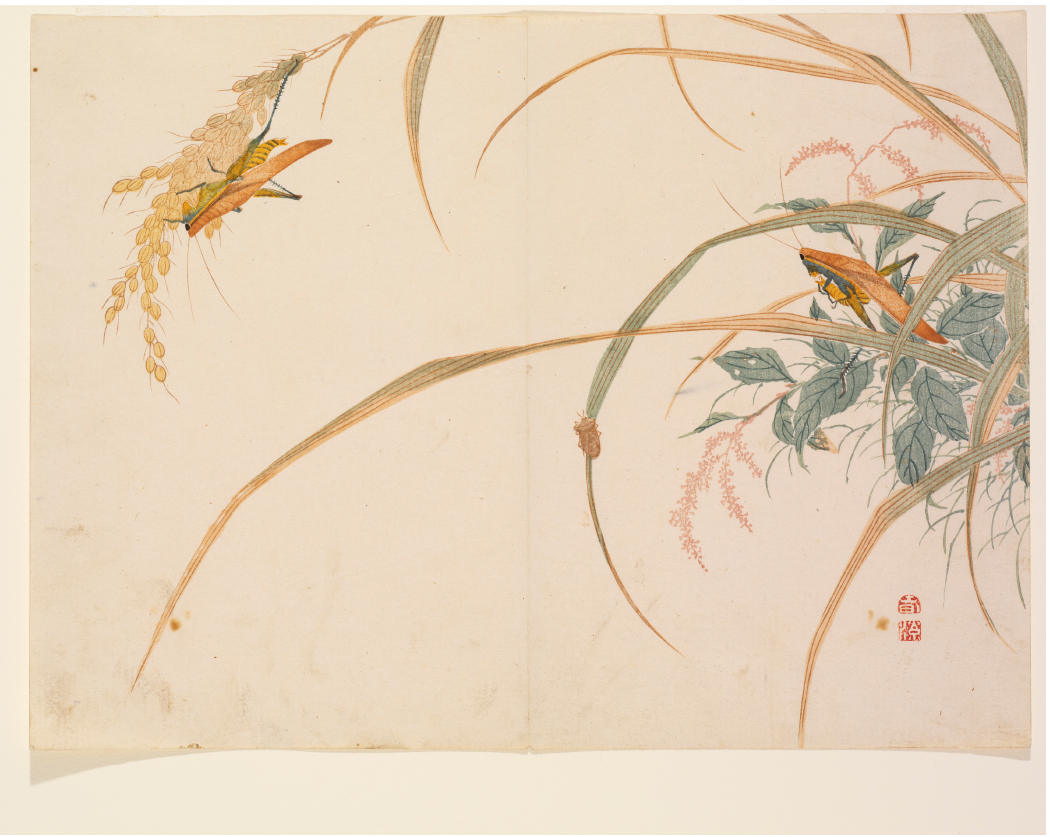
Figure 2. Grasshopper and bee, Things creeping under hand. Woodblock print by Mori Shunkei, 1820. [80].